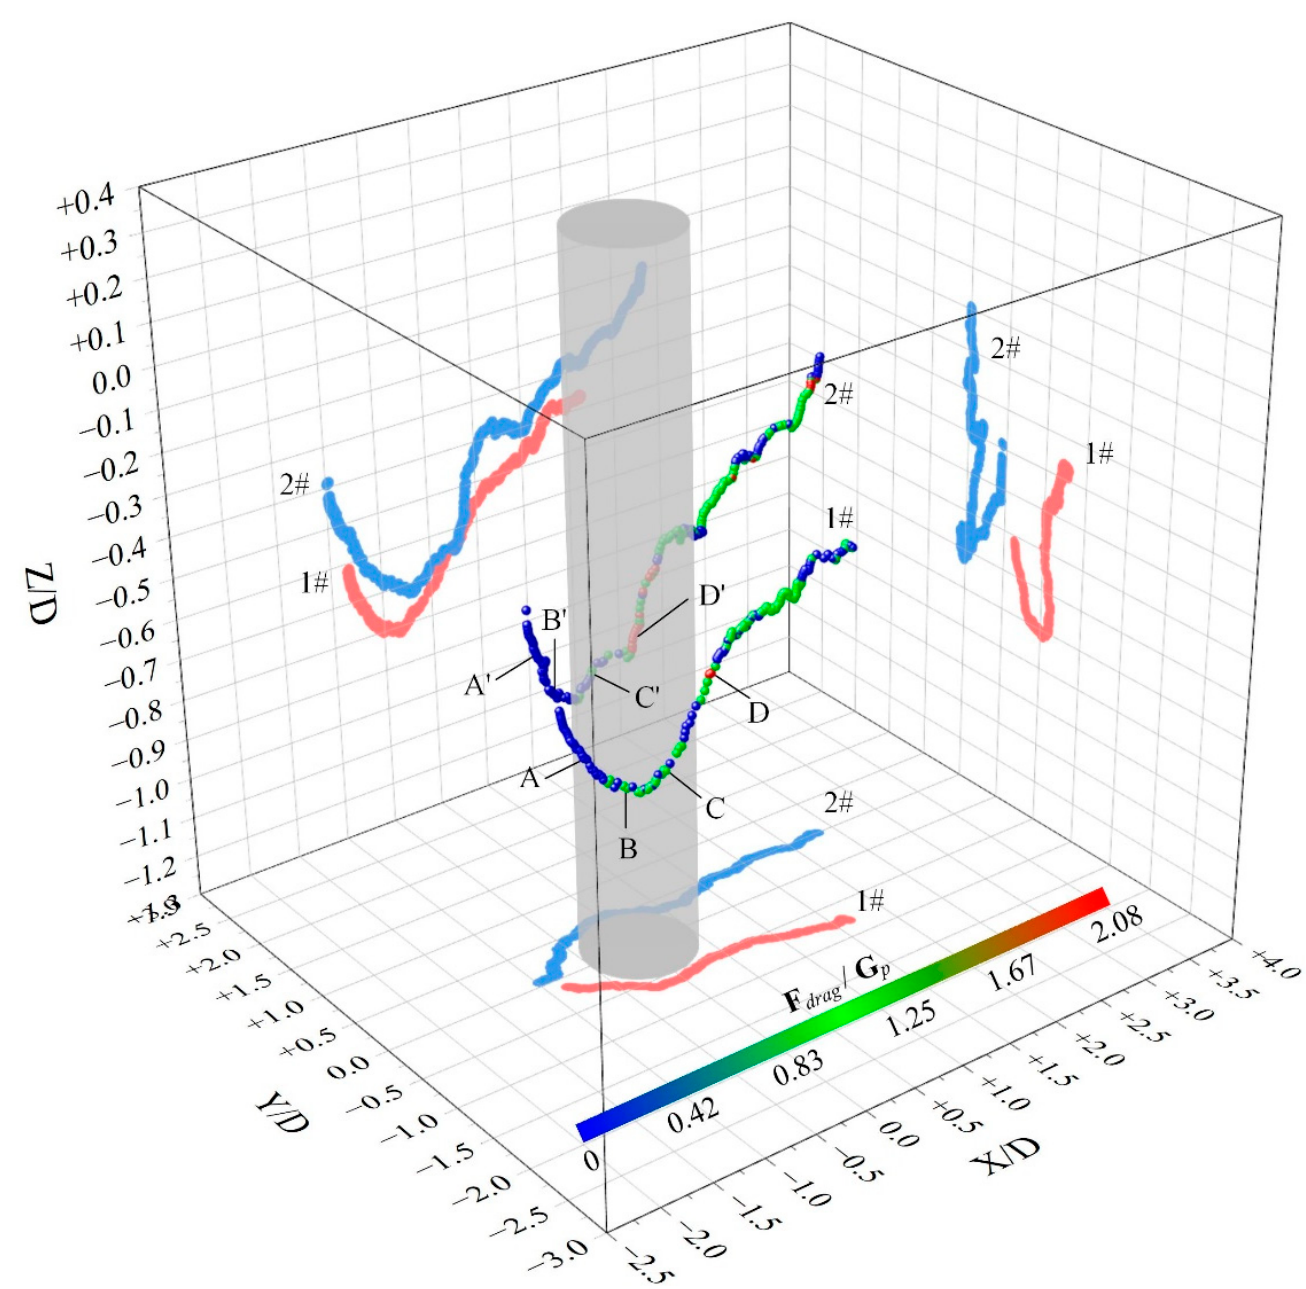
Figure 16. The trajectory of particles and the projection on three coordinate planes. 1 # and 2 # represent particle 1 and particle 2 respectively. The red and blue lines on the three coordinate planes represent the motion trajectory projection of particle 1 and particle 2 respectively.